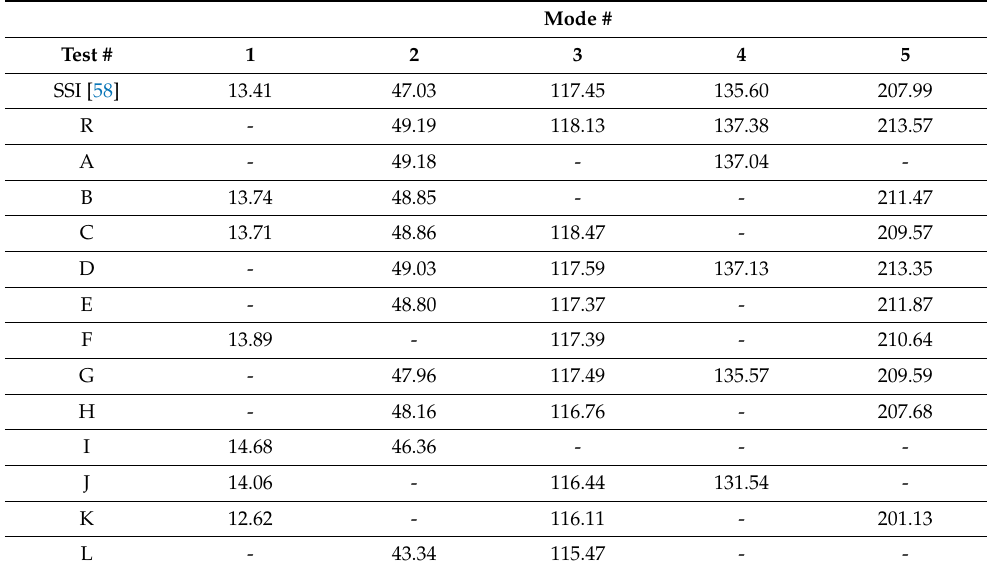
Figure 13. Fourier spectra of SOBI results obtained from the L+25 test conducted on the wind turbine blade. Table 6. Identified modal frequencies (Hz) of the wind turbine blade at +25 ◦ C using the SOBI